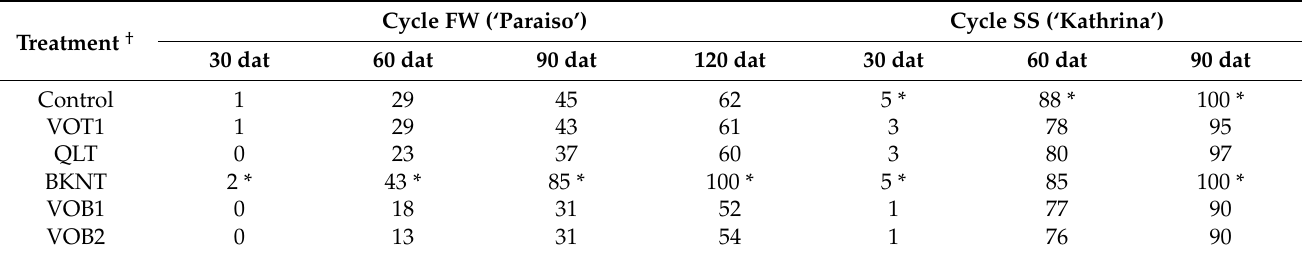
Table 5. Severity percentage of the downy mildew of cucurbits in cucumber crop, during the FW and SS cycles, according to the Horsfall–Barratt method [21] for the development of a severity scale.